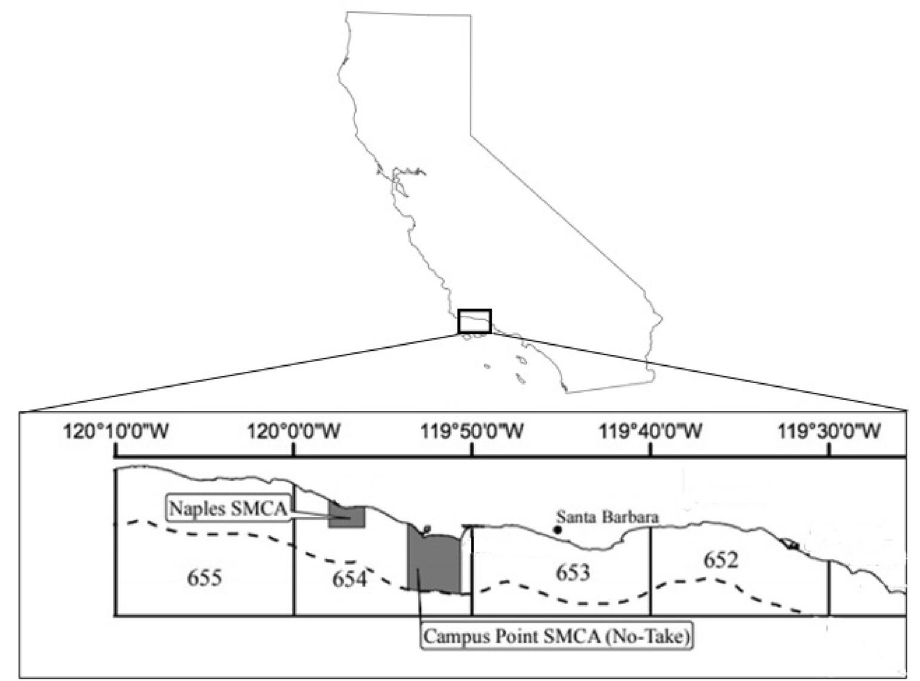
Figure 3. Map of CDFW designated fishing blocks off the mainland coast of Santa Barbara, CA USA. The dashed line marks the 3 nautical mile offshore state boundary of the fishing blocks. Grey polygons show the locations of the two MPAs at Campus Point and Naples Reef established in 2012. (For inset map of MPAs, see California Department of Fish and Wildlife (2021). https ://nrm.dfg.ca.gov/FileH andle r.ashx?Docum entID =13535 6&inlin e, p.